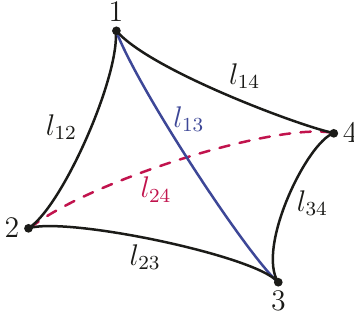
Figure 2 . The hyperboloid and projective models of hyperbolic space, as they appear embedded in E n (cid:0) 1 ; 1 . In the hyperboloid model, points in hyperbolic space belong to the upper branch of the hyperboloid, while in the projective model they belong to the x n = 1 hyperplane. The points in these two models are in one-to-one correspondence, and are identi(cid:12)ed when they lie on the same line passing through the origin of the embedding space.